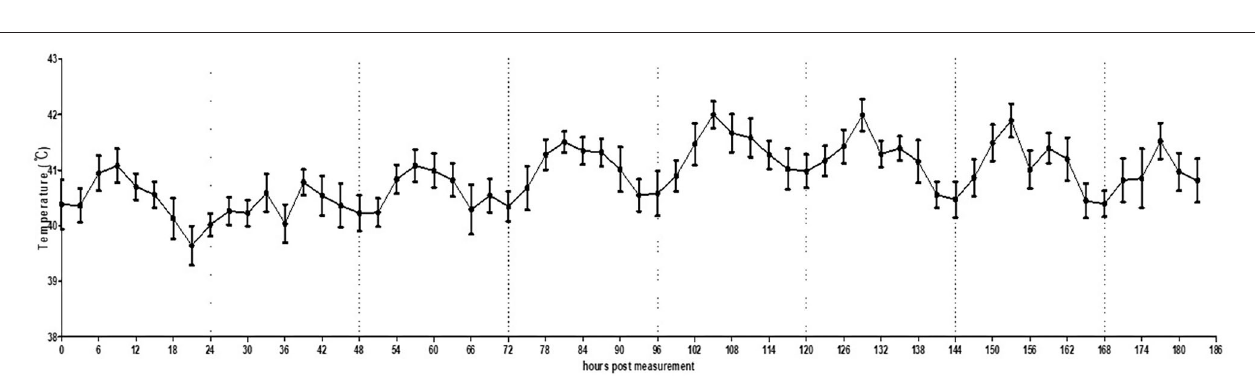
FIGURE 6 | Average temperature per 3h interval of broilers housed in an actual farm. The error bars represent standard deviations of 36 5-min time points. Thermography was performed for 7